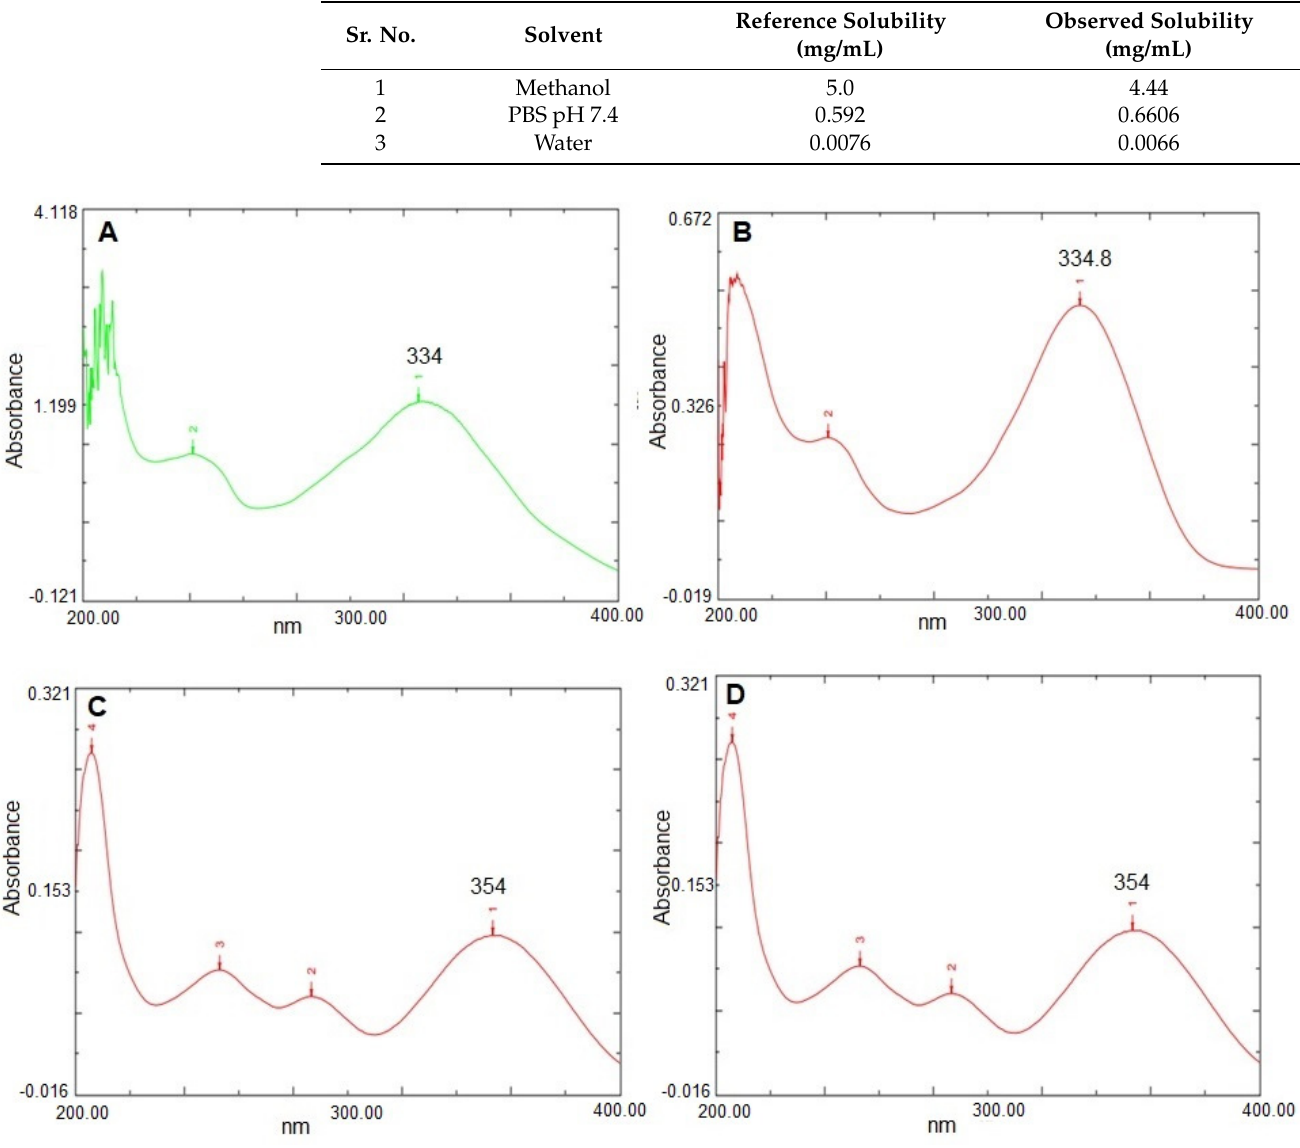
Figure 1. UV spectra depicting λ max of PRX in methanol ( A ), methanolic HCl ( B ), PBS pH 6.8 ( C ) and PBS pH 7.4 ( D ).